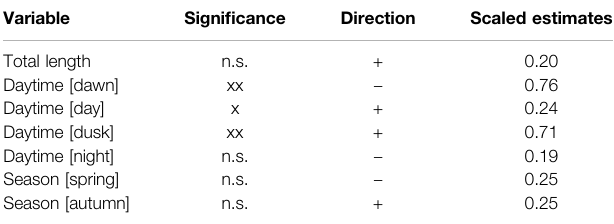
TABLE 4 | The signi fi cance, scaled estimates and impact direction of parameters and factors on weight-based fullness (Hyslop, 1980) of Perca fl uviatilis from Lake Constance in autumn 2018 and spring 2019; N (cid:2) 235 (GLM; r 2 adj. : 0.2903; p < 0.0001; f-value (cid:2) 0.6503; DV (cid:2) Weight-based fullness). Variable